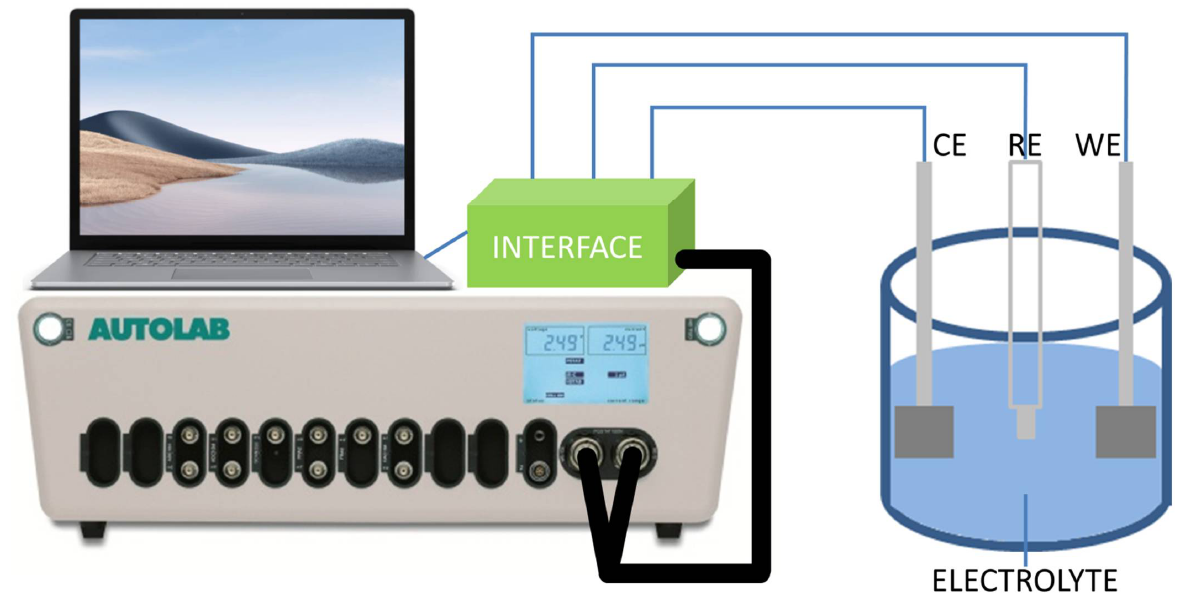
Figure 1. Schematic diagram of electrochemical testing setup.